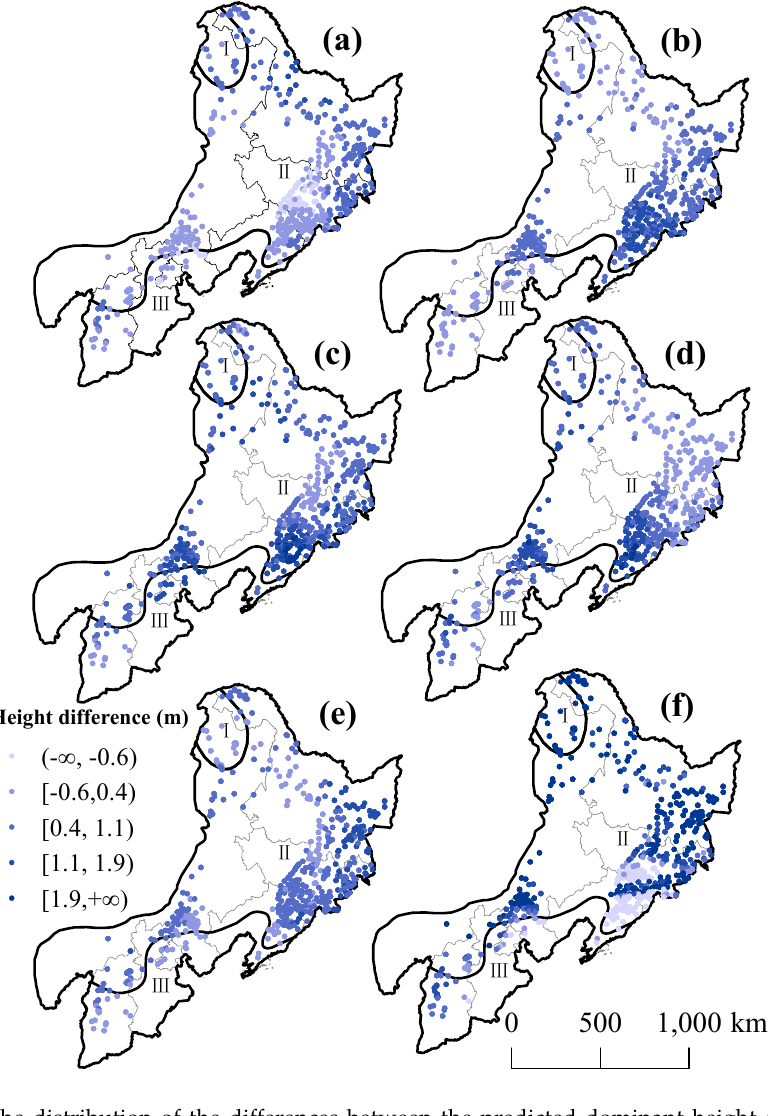
Figure 4. The distribution of the differences between the predicted dominant height of different climate scenarios and the current predicted dominant height, ( a ) RCP2.6 during the period 2041–2060; ( b ) RCP2.6 during the period 2061–2080; (c) RCP4.5 during the period 2041–2060; ( d ) RCP4.5 during the period 2061–2080; ( e ) RCP8.5 during the period 2041–2060; ( f ) RCP8.5 during the period 2061–2080. The bold line shows the climatic zones: I for the cold temperate zone, II for the mid temperate zone and III for the warm temperate zone; the geographic coordinate system of these maps is GCS_Clarke_1866.